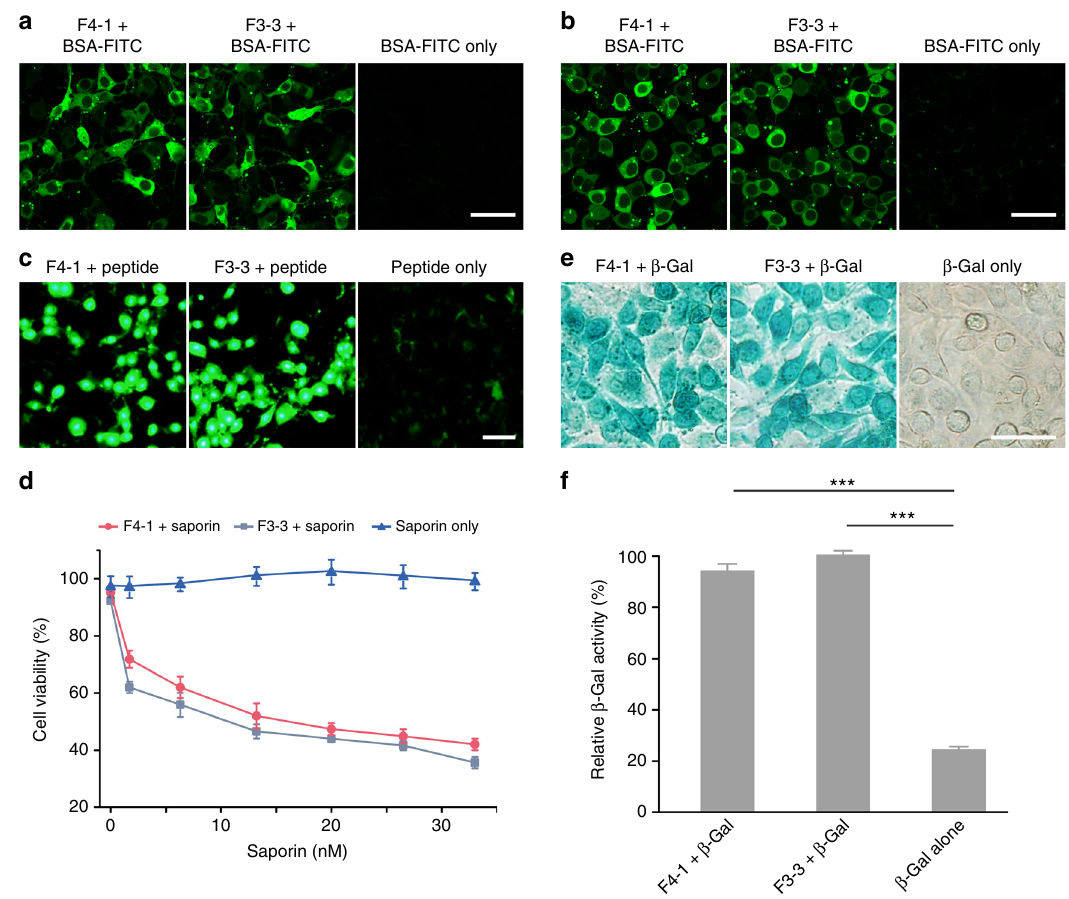
Fig. 5 Fluoroamphiphiles in protein delivery. Confocal images of NIH3T3 ( a ) and HEK293 ( b ) cells treated with the nanocomplexes for 4 h. c Fluorescence images of HeLa cells transfected with the complexes for 4 h. A volume of 4 μ g BSA-FITC or 1 μ g peptide-FITC was complexed with 2 μ g F4-1 and 2.5 μ g F3- 3, respectively. A representative result from three independent experiments. d Concentration-dependent toxicity of saporin and fl uoroamphiphile/saporin complexes on HeLa cells. Data are presented as mean ± s.e.m. ( n = 5). X-gal staining ( e ) and relative β -Gal activity ( f ) of HeLa cells treated with the complexes for 4 h. 5 μ g β -Gal, 2 μ g F4-1, or 2.5 μ g F3-3 were used. A representative result from three independent experiments for e , data are presented as mean ± s.e.m. ( n = 6) for f . *** p < 0.001 analyzed by Student ’ s t -test, one tailed. The scale bar in the fi gure is 50 μ